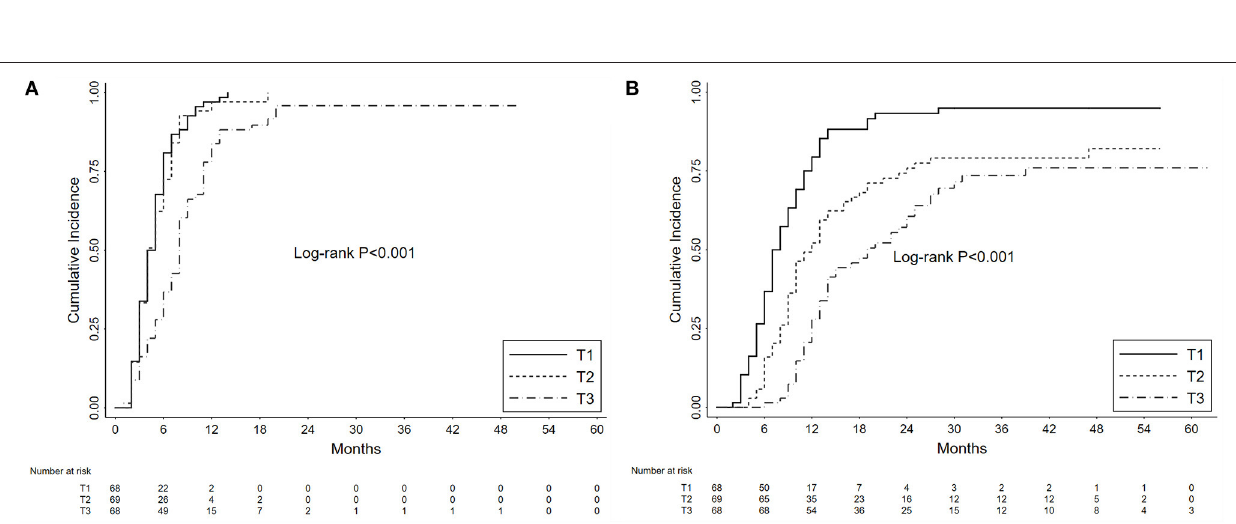
TABLE 2 | Univariate and multivariate analyses of independent prognostic factors of partial remission. Factor